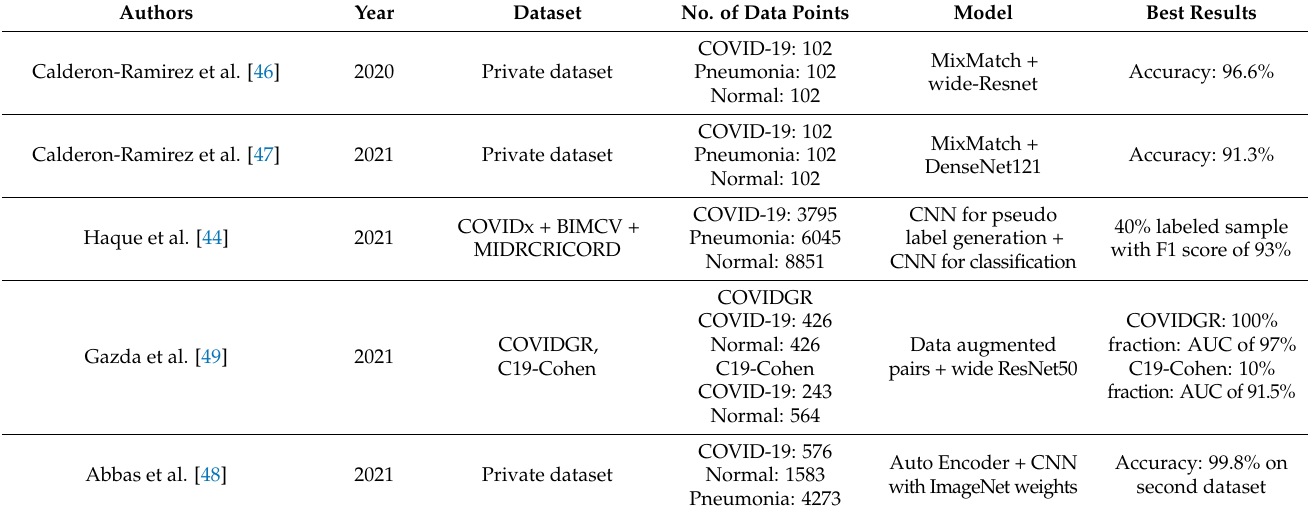
Table 4. Summary of work using semi-supervised deep learning for COVID-19 classification through